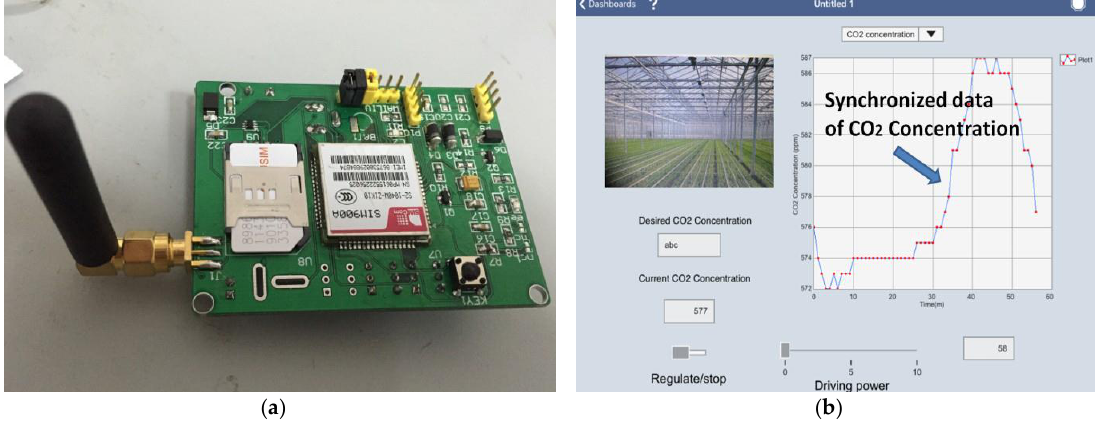
Figure 15. Data synchronization through a browser.